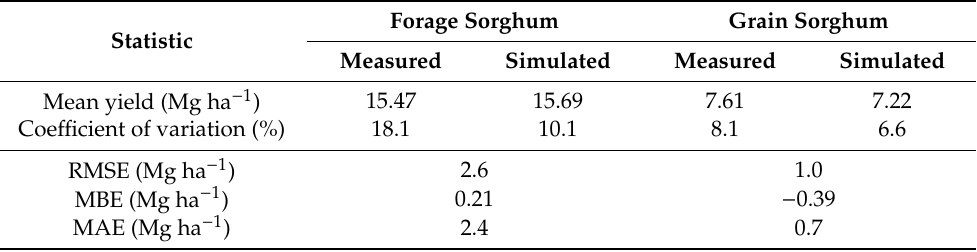
Table5. AgriculturalLandManagementAlternativeswithNumericalAssessmentCriteria(ALMANAC) model performance statistics for predicting forage and grain sorghum